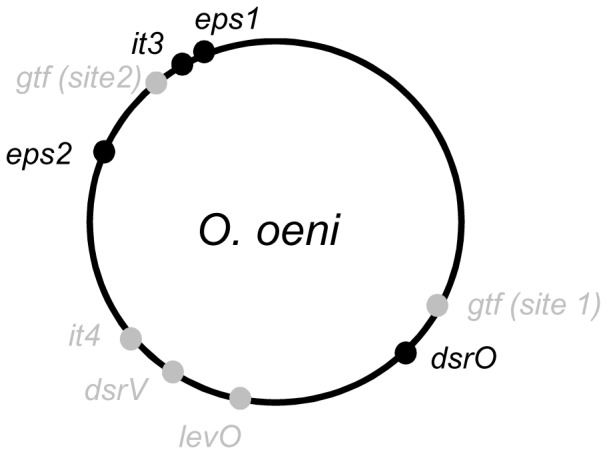
Schematic representation of the eps loci on the chromosome of O. oeni.The chromosome of O. oeni PSU-1 is represented with its own eps genes or loci (black). The position of the adjacent regions of the additional loci found in other O. oeni strains are presented in gray: eps1 and eps2: heteropolysaccharide clusters; gtf: β-glucan synthase gene; it3 and it4: priming glycosyltransferase isolated genes; dsrO and dsrV: dextransucrase genes; levO: levansucrase gene.